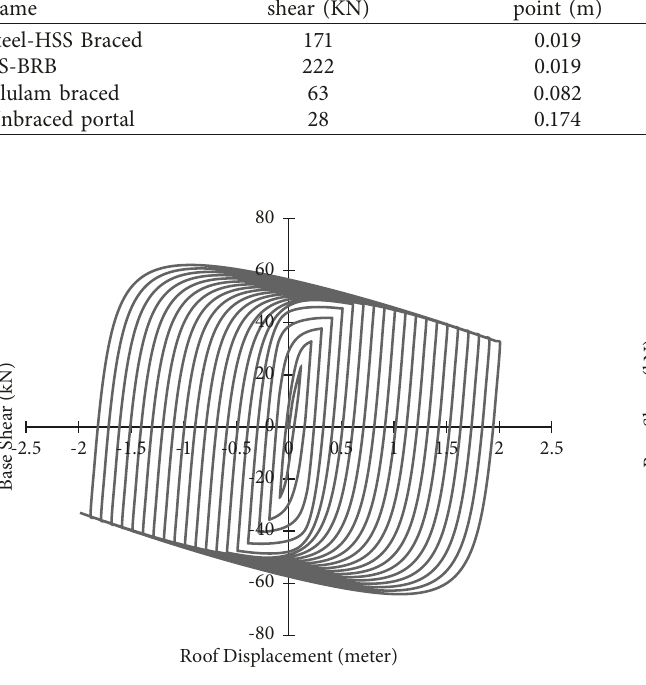
Figure 21: Glulam braced portal frame hysteresis curve.